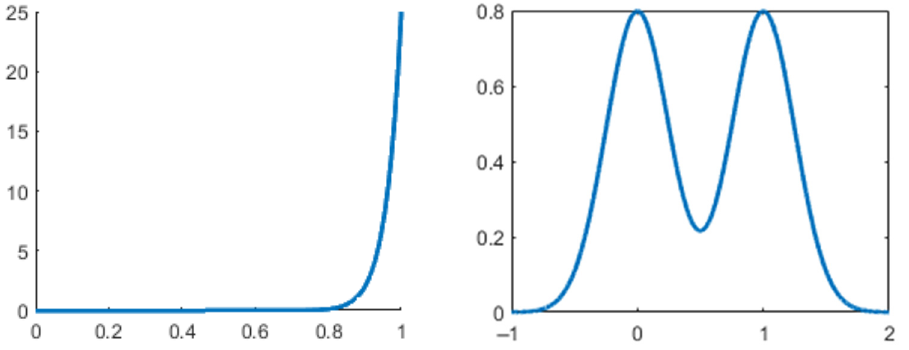
Figure 1. Unimodal distribution ( left ) with high BC (0.8), and bimodal distribution ( right ) with low BC (0.58).